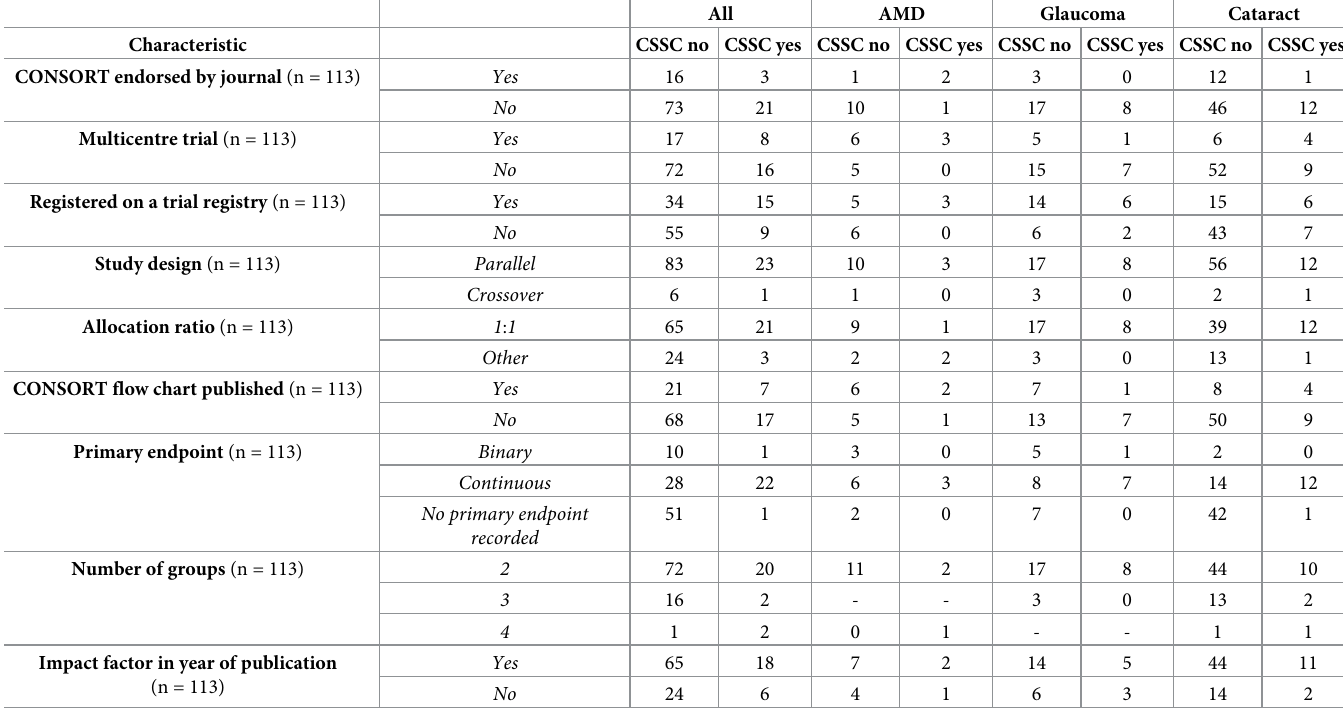
Table 3. Study characteristics